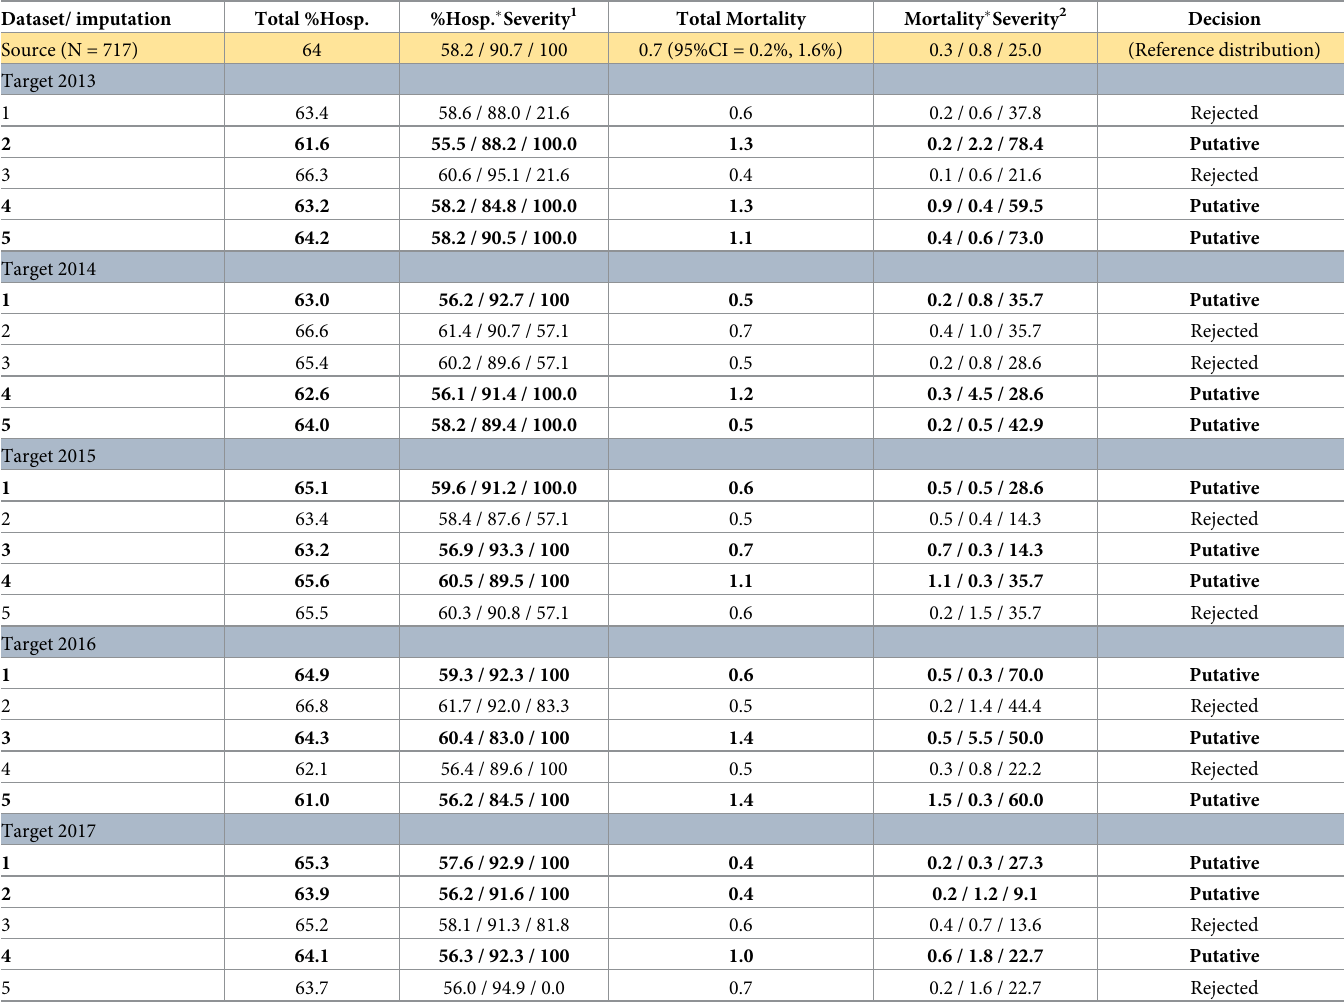
1 Values are percentage of hospitalizations among cases of dengue without warning signs / dengue with warning signs / severe dengue, respectively; value are mortality rates among cases of dengue without warning signs / dengue with warning signs / severe dengue, respectively. %Hosp.: Percentage of hospitalizations; CI: confidence